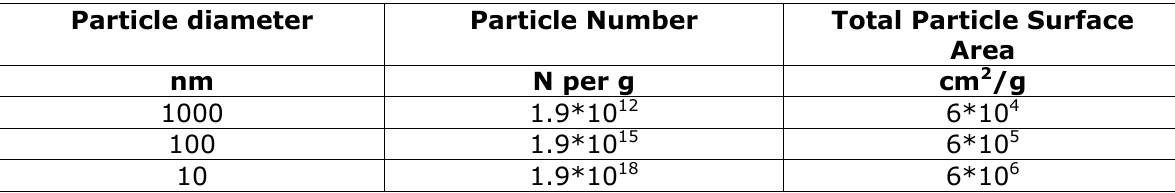
Table 1. Particle size and Surface